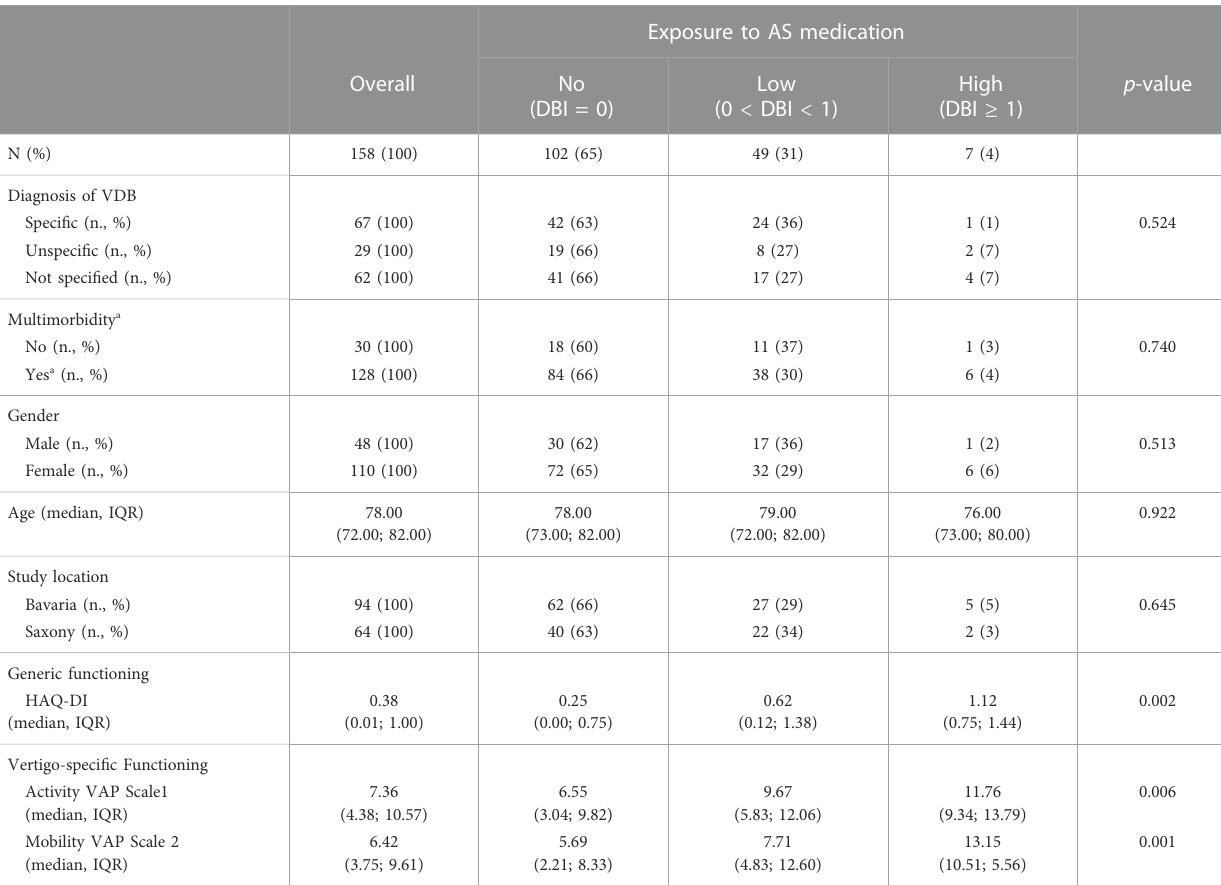
TABLE 1 Unadjusted summary statistics by exposure to AS medication at baseline assessment (n = 158). Median values and interquartile range for continuous variables and absolute and relative frequencies for categorical variables are